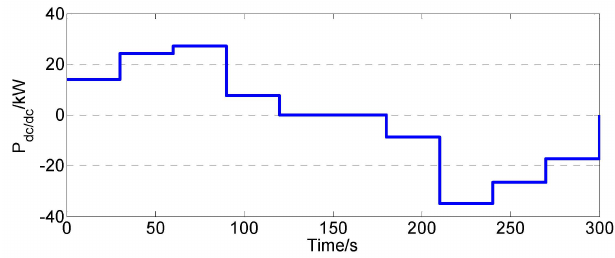
Figure 27. The simulation results when the UC bank is 1000 V.